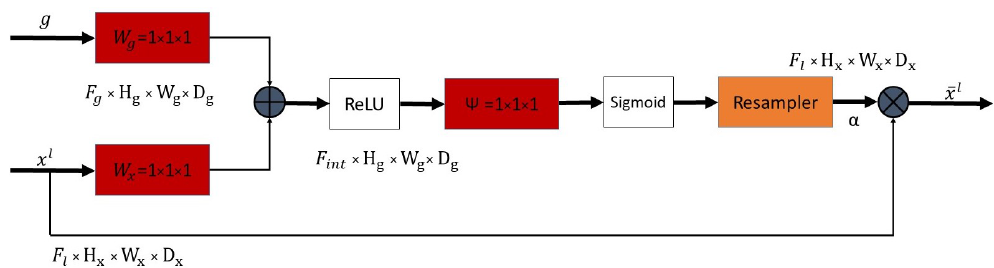
Figure 1. Attention module used in the Attention U-Net. It takes two inputs: g and x l where g is the higher-level feature and spatially smaller than the previous layer feature x l . g is used to guide lower-level features x l to emphasize relevant image regions. This is achieved by calculating α coefficients that are element-wise multiplied with x l to produce attention maps. Adapted from